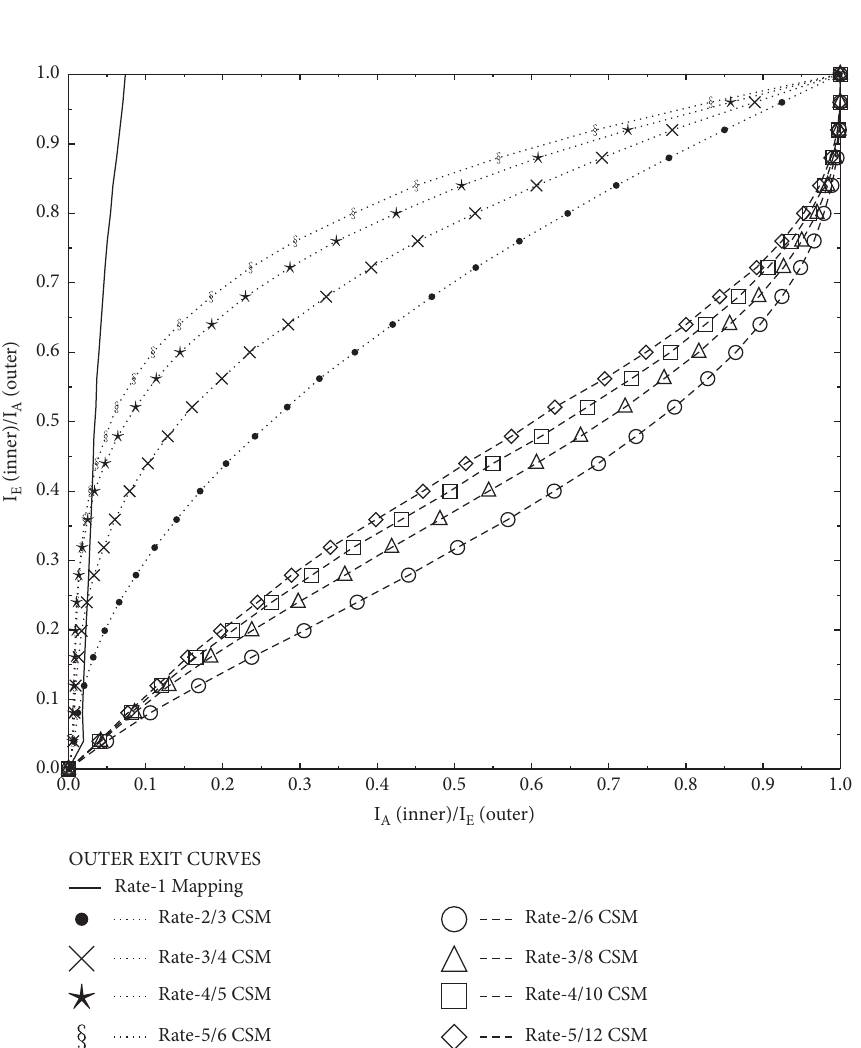
Figure 3: EXIT curves for error protection schemes employing different outer (CSM) and inner (RSC) rates.